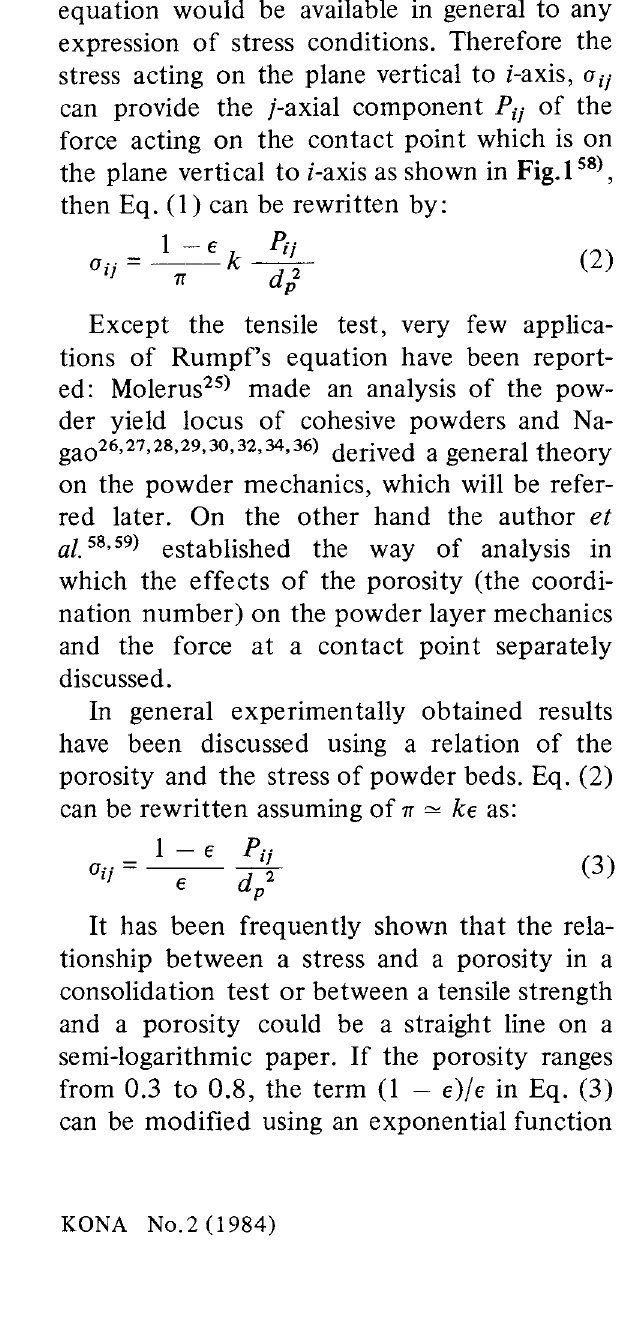
Fig. 1 Schematic representation of Pi; and aii